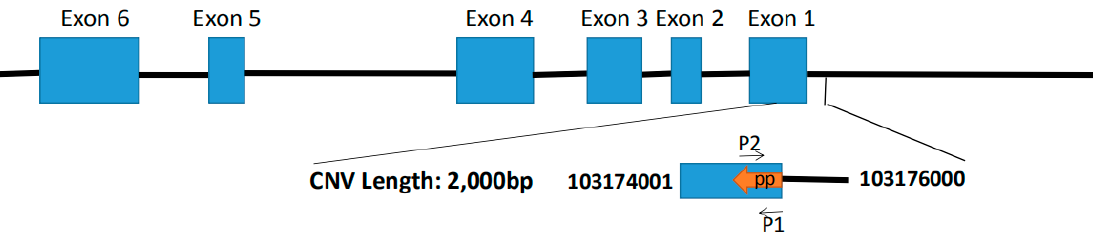
Figure 1. The region of the SHE gene’s copy number variation (CNV) in sheep breeds. The blue boxes indicate the coding area. The CNV region starts at 103174001 to 103176000 in Chr1 (Huang et al.). pp. (primer pair-CNV): 103174905 to 103175078, the detection sequence size is 174 bp.